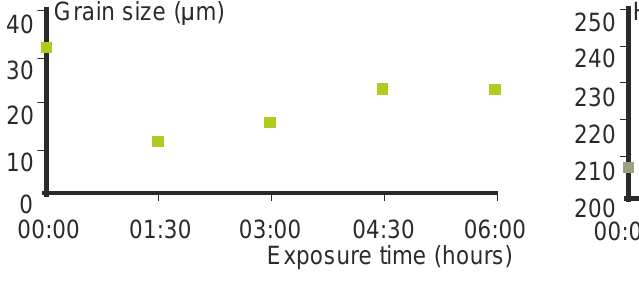
Figure 9. (a) Grain size versus exposure time, 20NC6 steel (adapted from [22]). (b) Hardness (Brinell) versus exposure time, 20NC6 steel (adapted from